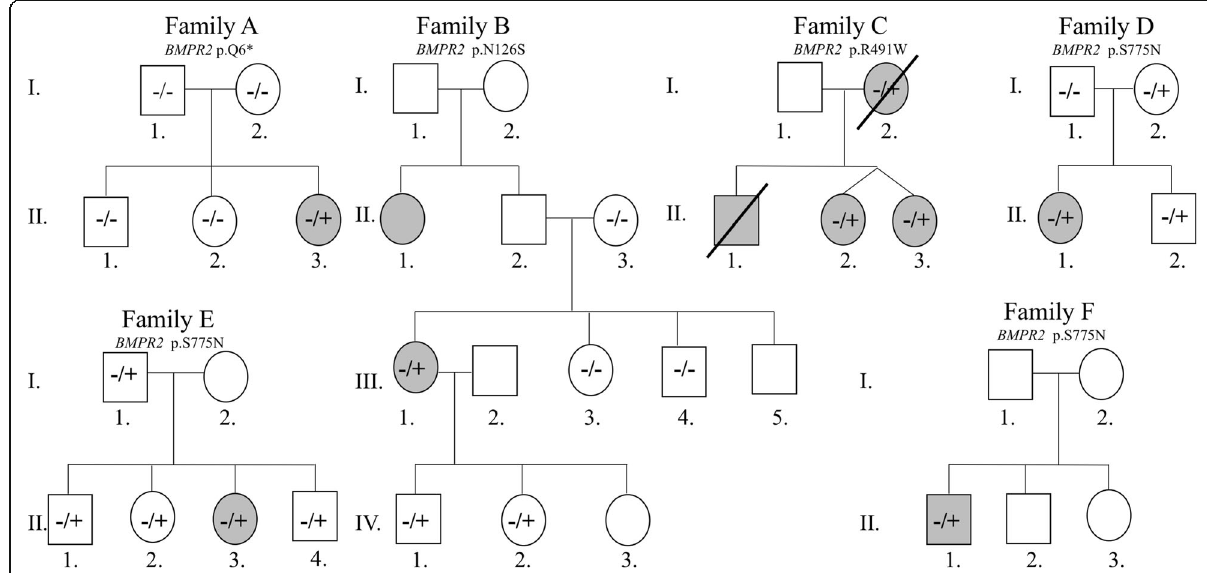
Fig. 2 Pedigrees for families showing the different BMPR2 mutations. The − / − symbol is for normal genes, − /+ is for heterozygous mutations and the +/+ is for homozygous mutations. Square, Male; Circle, female; open symbol, unaffected; filled symbol, affected; symbol with diagonal line, dead